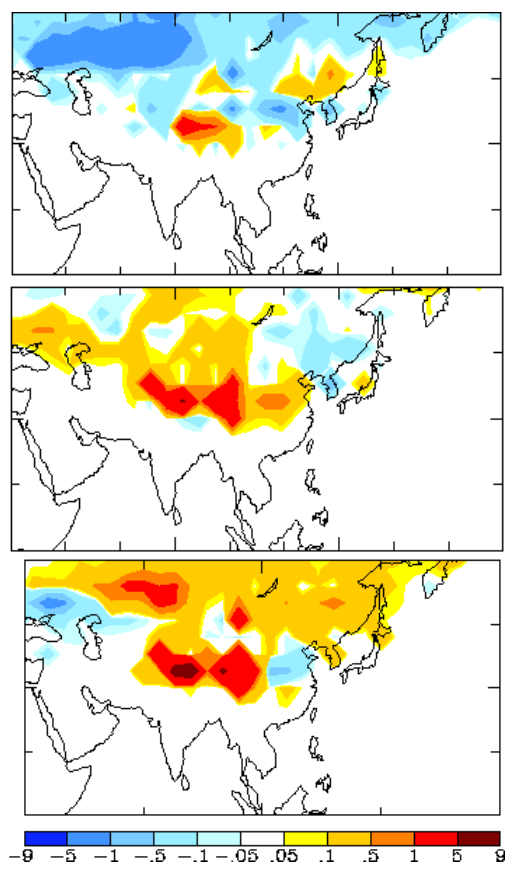
Fig. 6. Differences in annual average forcing (0.1Wm − 2 ) from changes to snow/ice albedo due to black carbon (BC) deposition on snow/ice surfaces for simulations that also include the direct and indirect effects. The top panel represents the simulation with the Beig emission changes from 1990 to 2000 along with climate driven changes (from changes to sea-surface temperatures). The middle panel represents differences due to BC used in the Beig and Bond emissions for present-day (Year 2000) and the bottom panel represents future changes (from 2000 to 2010) from BC for the Beig emissions.